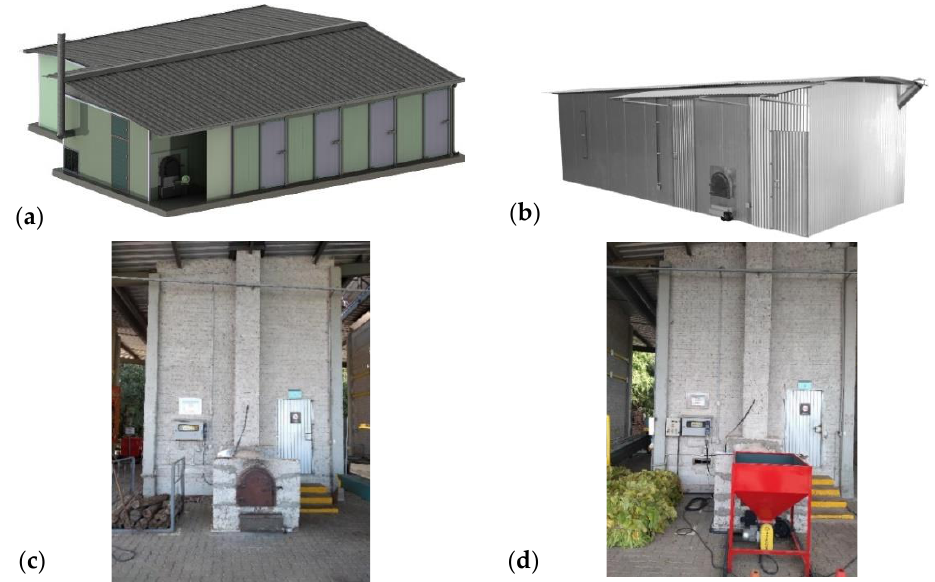
Figure 1. ( a ) Continuous load CU (Chongololo), ( b ) Forced air CU, ( c ) conventional CU, and ( d ) conventional adapted for pellets CU. Source: images “a” and “b” available on the manufacturer’s website: http://www.be1.com.br (accessed on 25 November 2020) and images “c” and “d” photographed by the authors.